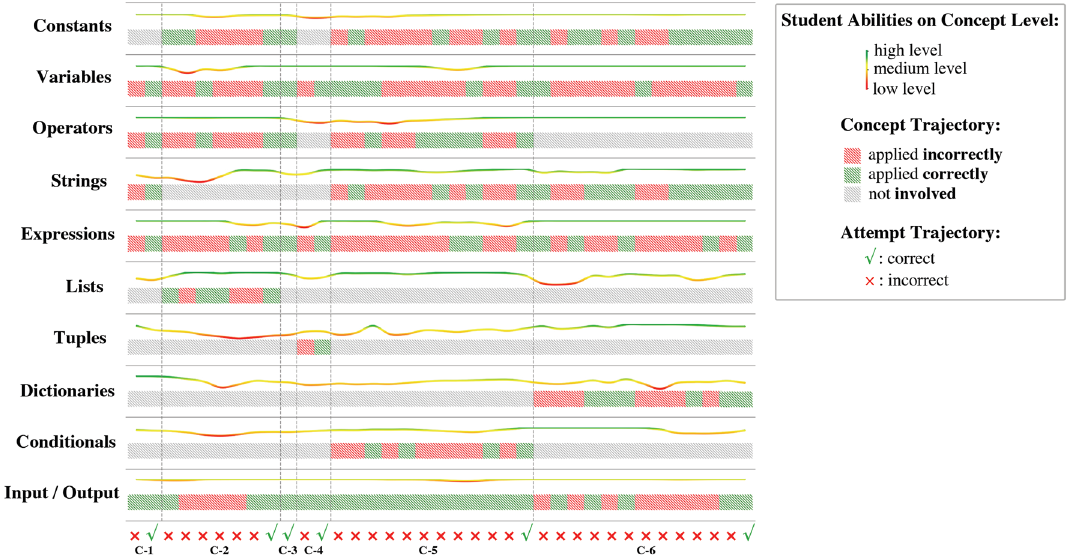
Figure 4. An example of a student’s submission trajectory from the dataset. The vertical axis shows 10 Python concepts, and the horizontal axis shows the attempt trajectory of the student over six challenges; × means the attempt is incorrect, while (cid:31) means that it is correct. In each concept area, student ability on a particular concept is presented by a curve in a different color. The curve in red means the student’s ability is at a low level, the yellow color indicates medium level, and the green color means the student masters the concept. Under the student ability curve, the blocks in red, green, and gray are used to show the student’s applying trajectory of each concept. The red block means the concept is applied incorrectly; the green one means the concept is applied correctly, and the gray one means this concept is not involved in the relevant